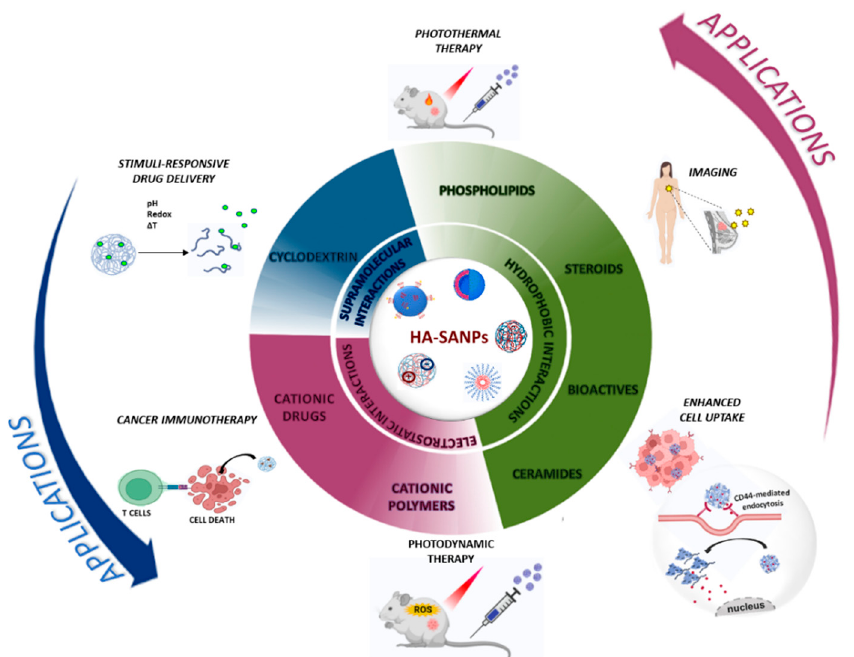
Figure 1. Applications of HA-SANPs for cancer theranostics: indication of the main mechanisms of HA-SANPs formation and the most representative derivatization agents.